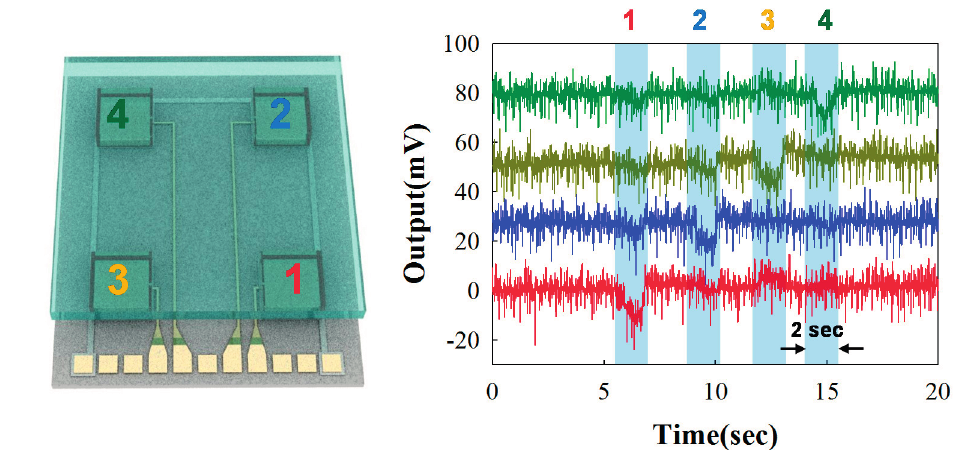
Figure 5. Electrical output signal under normal forces via static pressure with 30 kPa on each sensor unit.